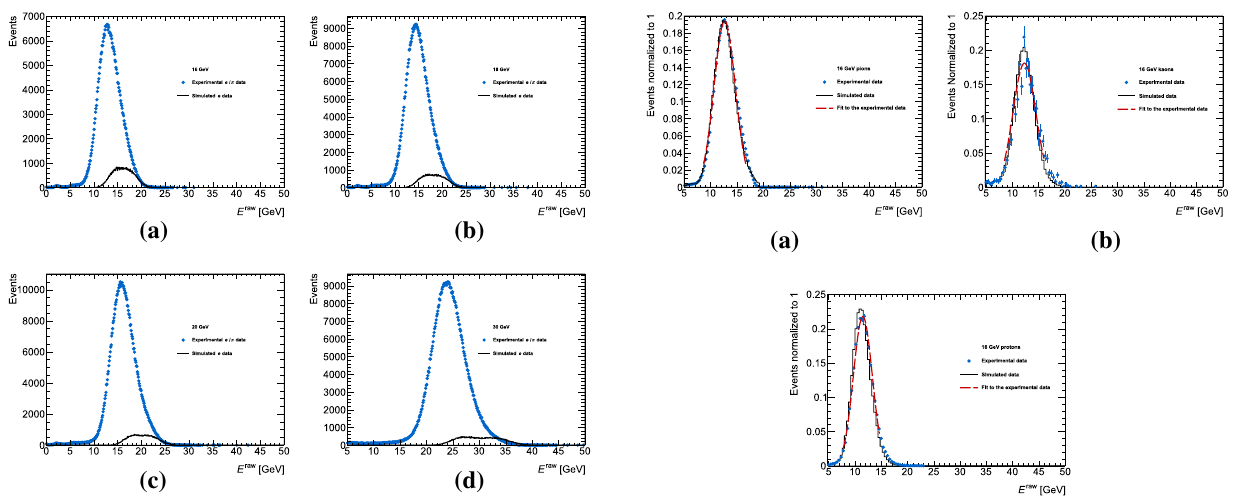
Fig. 14 The blue dotted histograms show the experimental data distri- butionsofthereconstructedenergy E raw ofthe e /π sampleseventswith E beam equalto16GeV( a ),18GeV( b ),20GeV( c )and30GeV( d ).The black dotted histograms, obtained using simulated events, correspond to the expected distributions of electrons contaminating the samples. The normalization procedure is described in Sect. 3.4